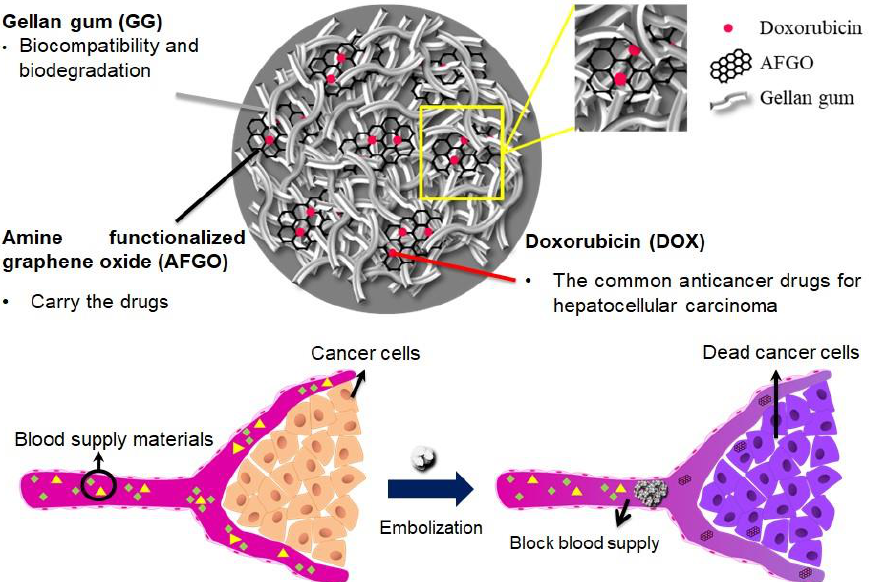
Figure 1. Scheme showing the embolic agent of microsphere-nanoparticle GG/AFGO – DOX blocking the blood supply and delivering AFGO – DOX in cancer